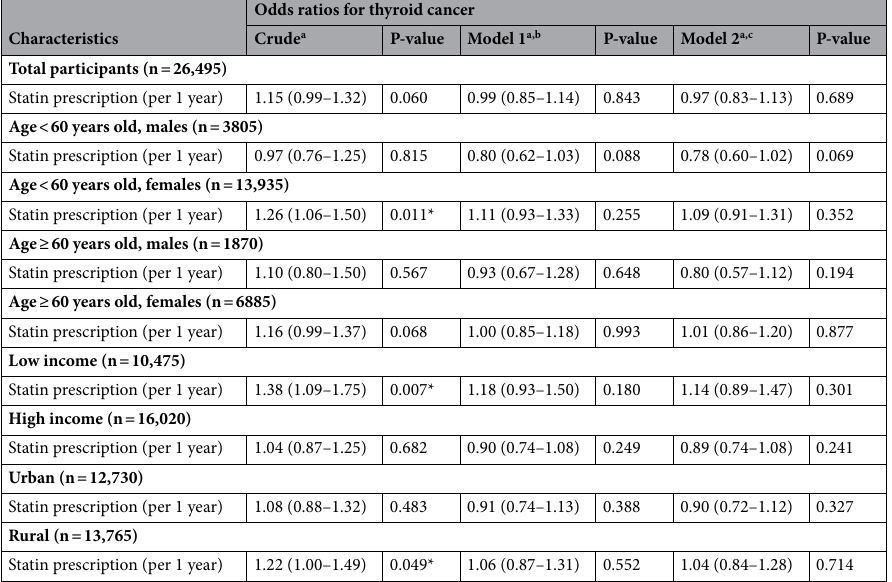
Table 3. Odds ratios (95% confidence interval) of the date of hydrophilic statin prescription (per 1 year) for thyroid cancer with subgroup analyses according to age, sex, income, and region of residence. CCI Charlson comorbidity index, DBP diastolic blood pressure, SBP systolic blood pressure. *Conditional logistic regression, Significance at P < 0.05. a Models were stratified by age, sex, income, and region of residence. b A model 1 was adjusted for dyslipidemia history, total cholesterol, SBP, DBP, and fasting blood glucose. c A model 2 was adjusted for model 1 plus obesity, smoking, alcohol consumption, and CCI scores.